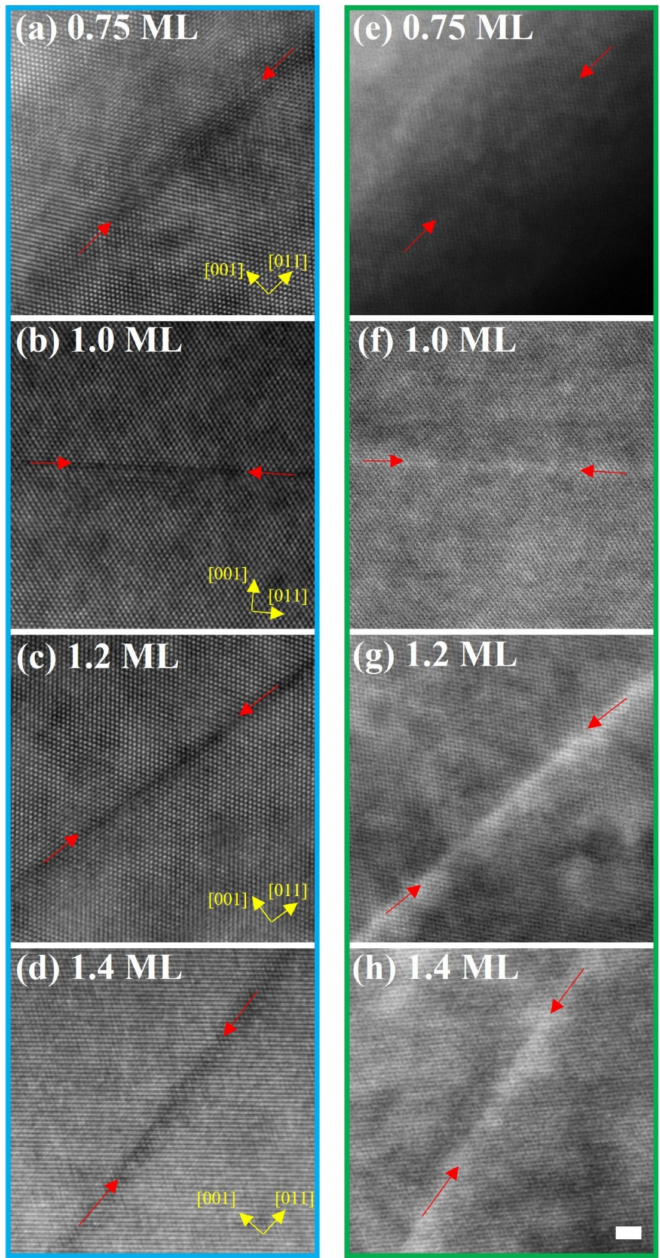
Figure 8. ( a – d ) HRTEM images of four samples with different amounts of InAs. ( e – h ) STEM images of relative samples with different InAs content. The InAs structures are indicated by red arrows, and the scale bar corresponds to 2